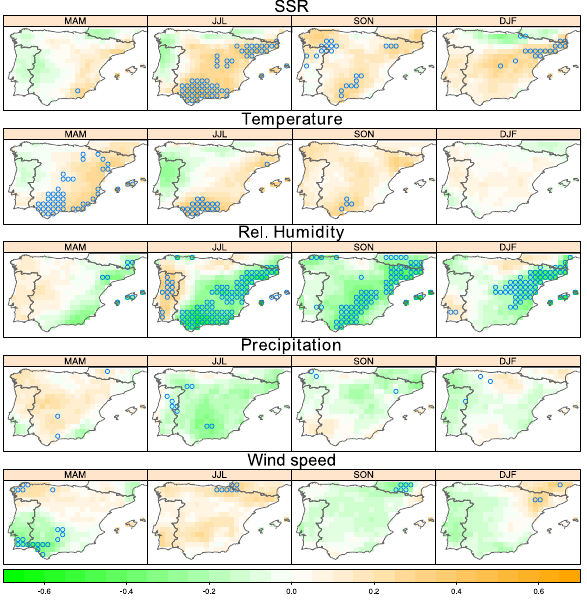
Fig. 3. Seasonal trends (modified Mann-Kendall’s trend test) for the period 1989–2011 of the seasonal severity rating (SSR) and the input variables temperature, relative humidity, precipitation, and wind velocity according to the ERA-Interim reanalysis. Legend represents Mann-Kendall’s Tau correlation coefficient. Significant trends ( p < 0 . 05) are indicated by circles.